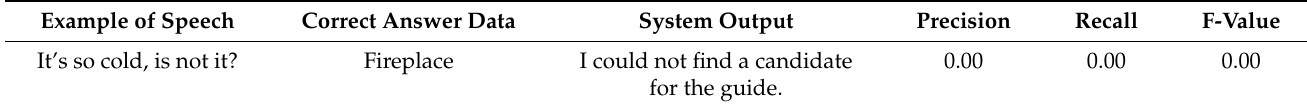
Table 7. Examples of failed utterances and system output.